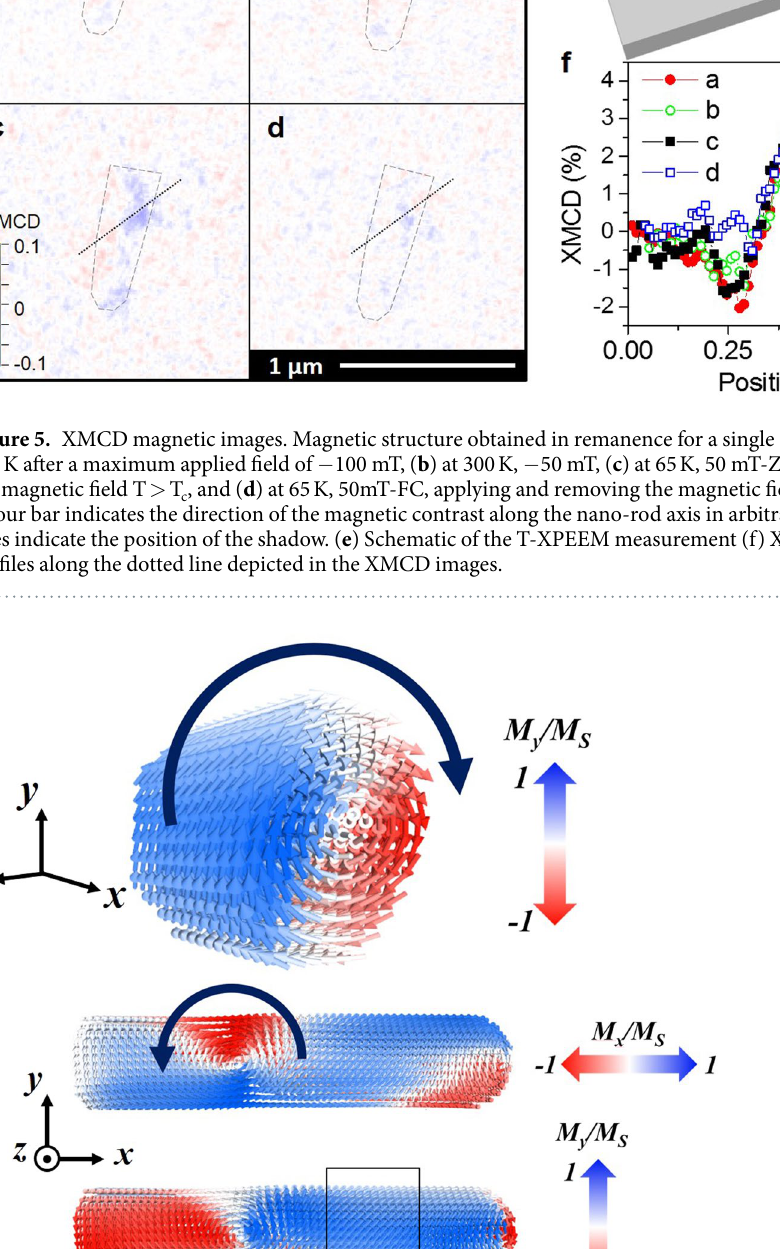
simulations have been used to elucidate the origin of this magnetic configuration. Figure 6 shows the simulated remanent state for a Co nano-rod obtained after applying a magnetic field of − 100 mT parallel to the nano-rod